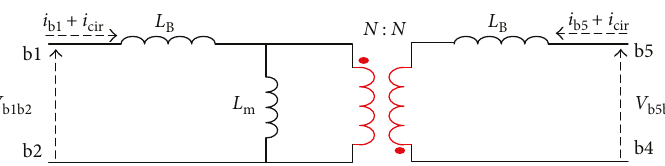
Figure 9: Equivalent circuit of the two-winding coupled inductor.